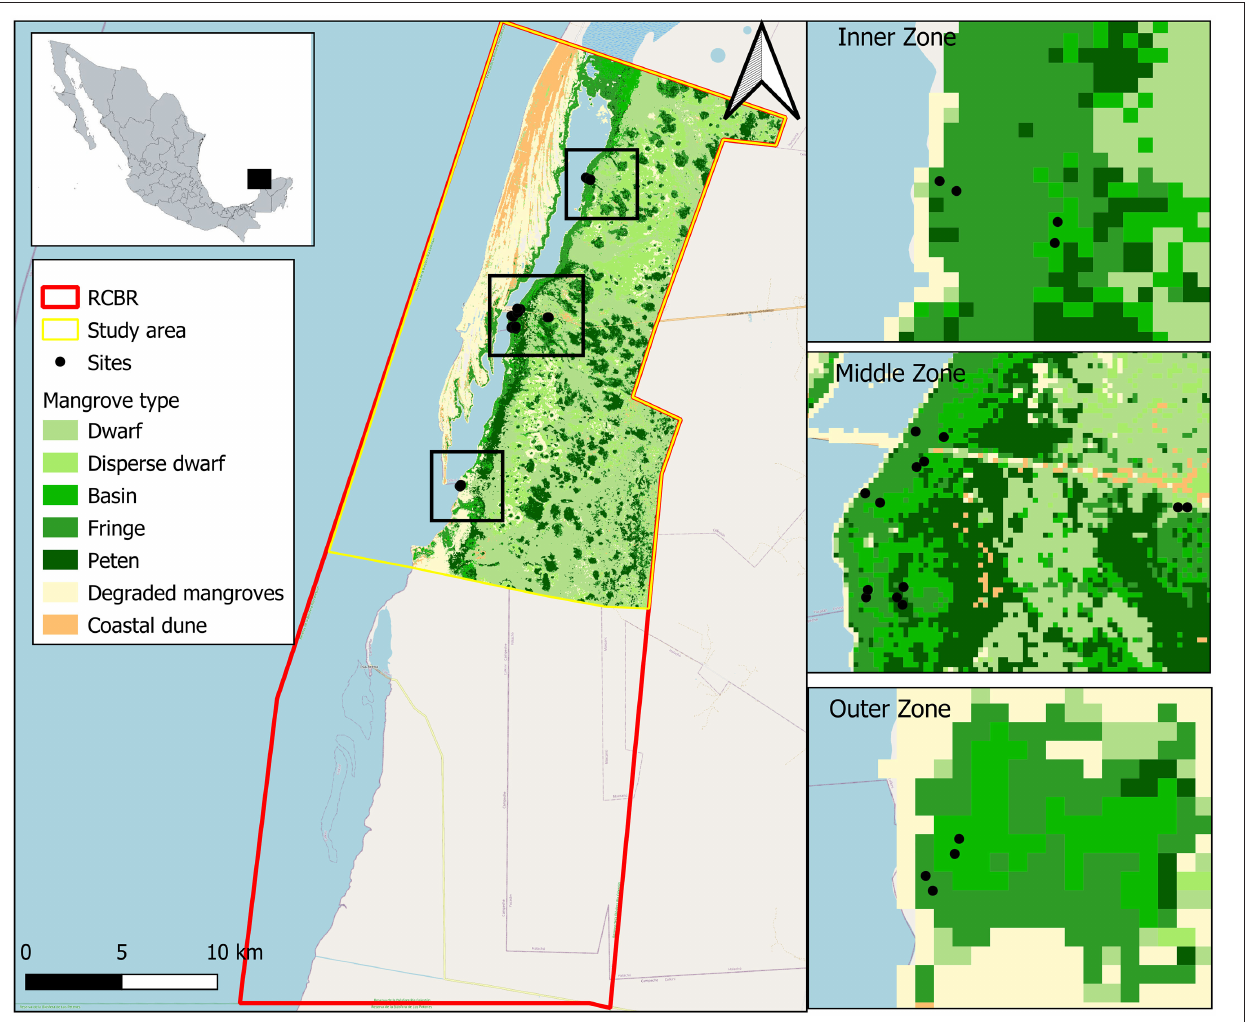
FIGURE 1 | Study sites in Celestun (Yucatan, México). Location by lagoon zones (distance among Inner, Middle, and Outer zones is 8km on average) and by mangrove ecological type (distance among fringe, basin, dwarf and peten mangroves varies from 300 to 1,500